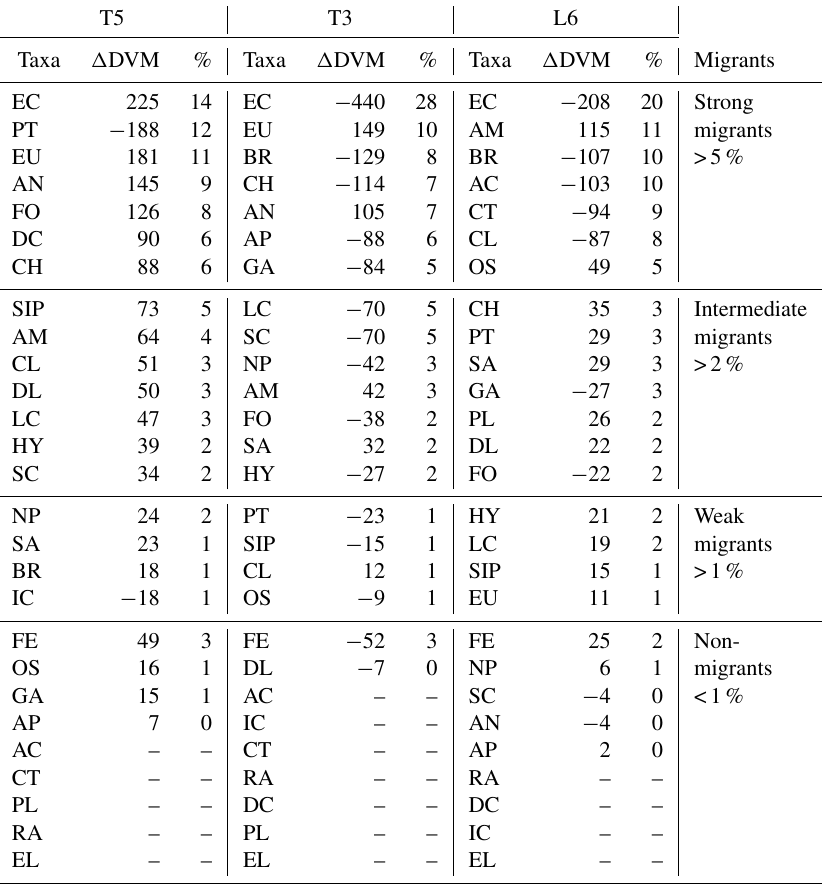
Table 1. Diel vertical migration indices for 27 taxonomic groups (Taxa) identified and sorted by ZooScan at three stations off northern Chile (see Fig. 3 for acronyms), during the austral spring 2015. Amplitude of migration ( (cid:49) DVM) is in meters. Positive values indicate normal DVM and negative values indicate reverse DVM (see Methods). Four groups are defined in according to DVM behavior. Relative abundances are shown in